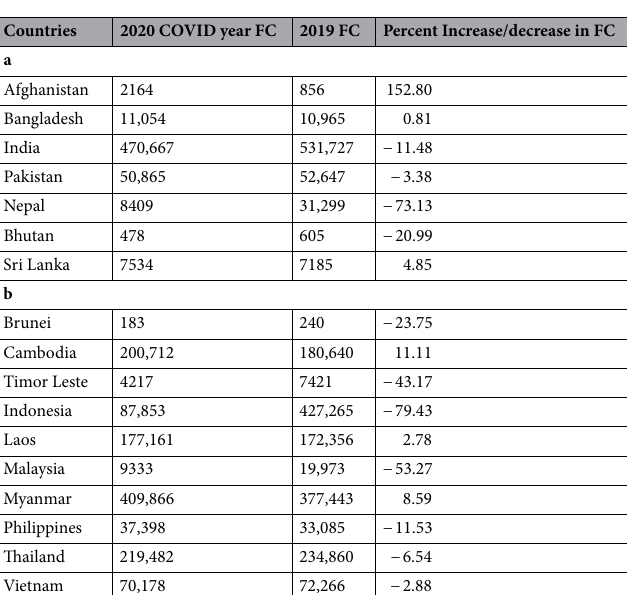
Table 2. a, b. Percent increase/decrease in VIIRS (375 m) derived fire counts in South/Southeast Asian countries during 2019 versus COVID year 2020.